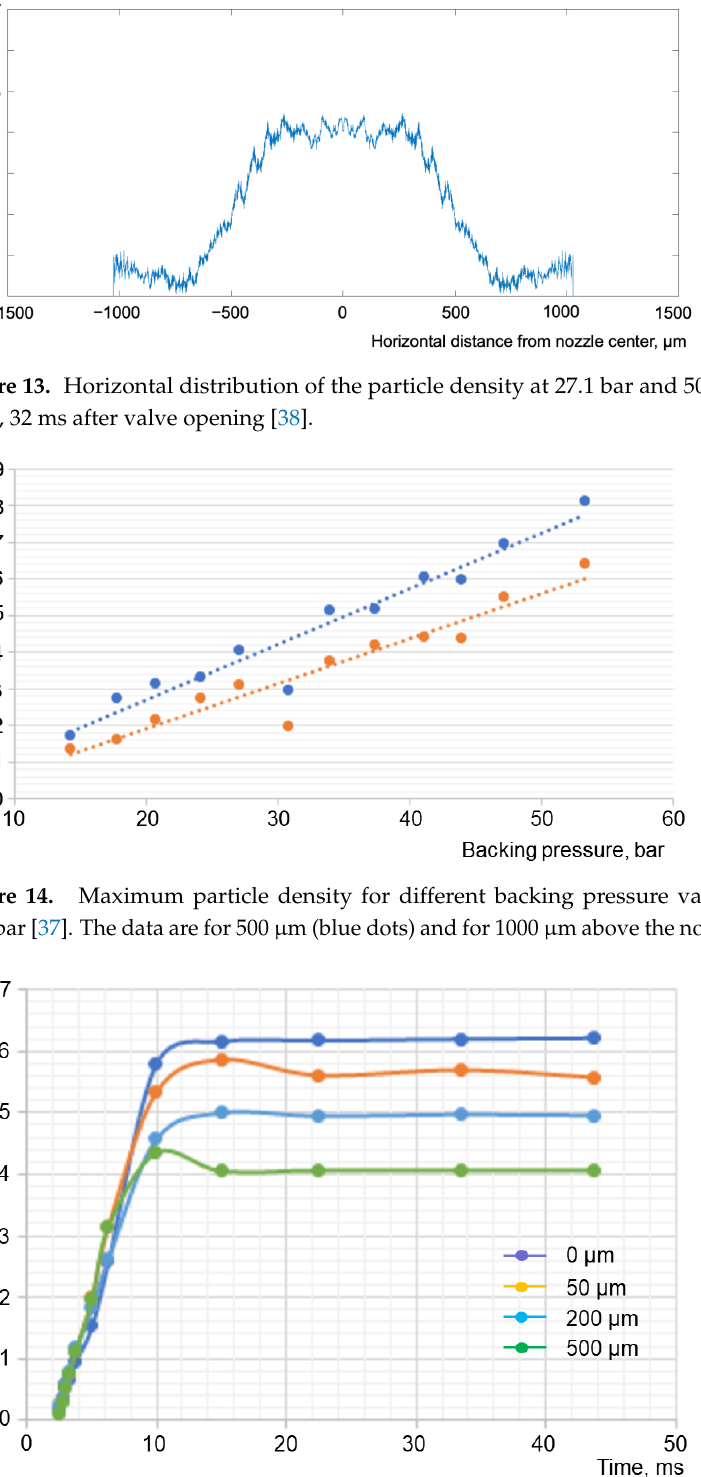
Figure 15. Time profile of the particle density for different heights above the nozzle edge at 27.1 bar backing pressure